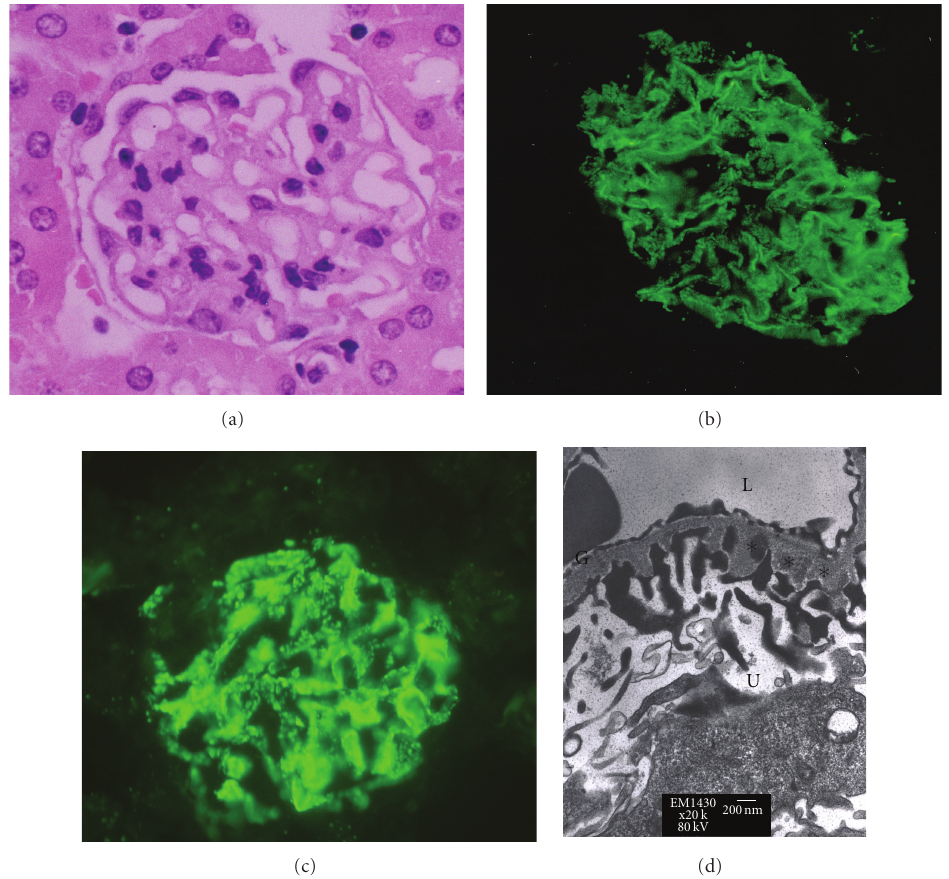
Figure 2: Renal histopathology in mice with MN. Histopathology revealed findings characteristic of di ff use basement membrane thickening, as observed in the (a) hematoxylin and eosin staining, (b) positive granular immunofluorescent staining for IgG, (c) positive granular immunofluorescent staining for C3, and (d) subepithelial deposition (asterisk). NC: normal control; MN: membranous nephropathy; G: glomerular basement membrane; L: lumen of capillary; U: urinary